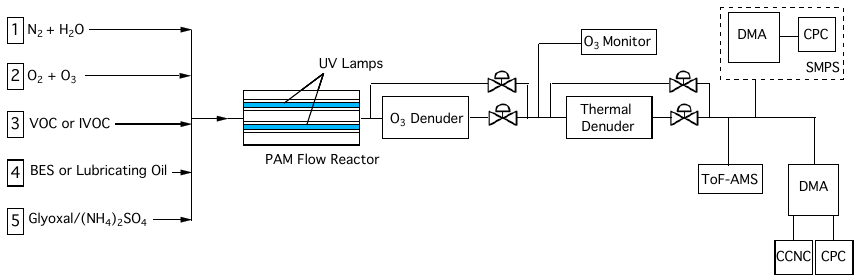
Fig. 1. Simplified schematic of experimental setup. As indicated, input lines 1 and 2 provide carrier gases (N 2 , O 2 ) and OH radical precursors (O 3 , H 2 O). Line 3, 4, and 5 provide precursors for SOA and OPOA production as described in Sect.